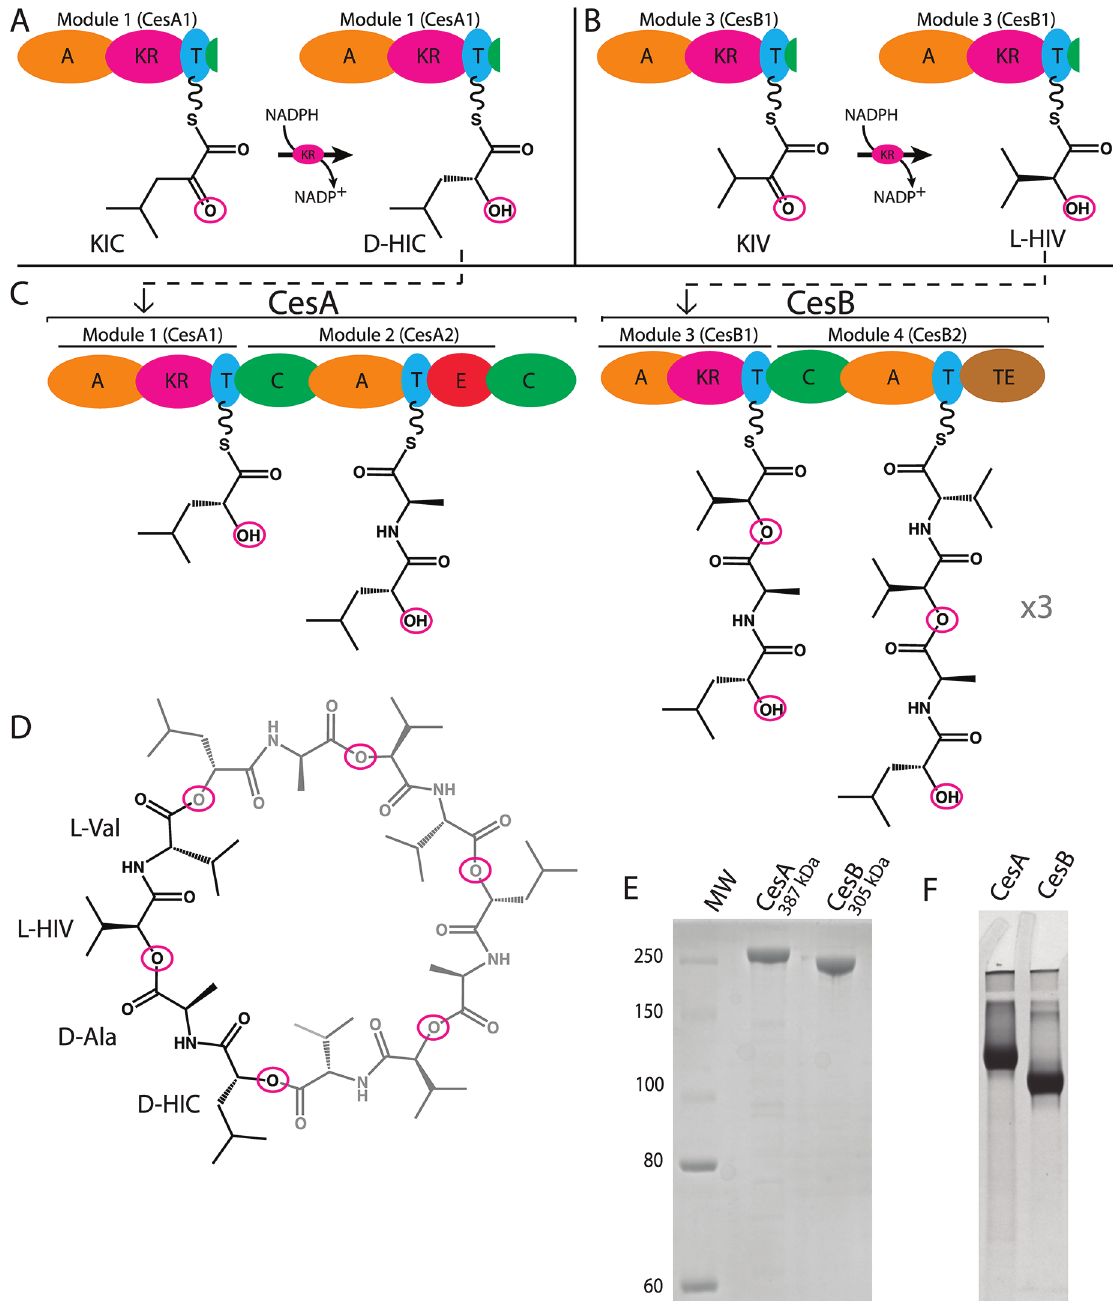
Fig 1. Cereulide synthetase produces the emetic toxin cereulide. (A and B) Modules CesA1 and CesB1 contain KR domains which catalyze the reduction of bound keto acyl groups. (C) Schematic diagram of cereulide synthetase and the synthesis of D-HIC — D-Ala — L-HIV — L-Val, which is trimerized to produce mature cereulide (D). (E) Denaturing and (F) native PAGE of NRPS proteins CesA and CesB. CesA and CesB migrate slightly faster than expected from their molecular masses. Domain abbreviations: A, adenylation; KR, ketoreductase; T, thiolation; C, condensation; E, epimerization; TE,